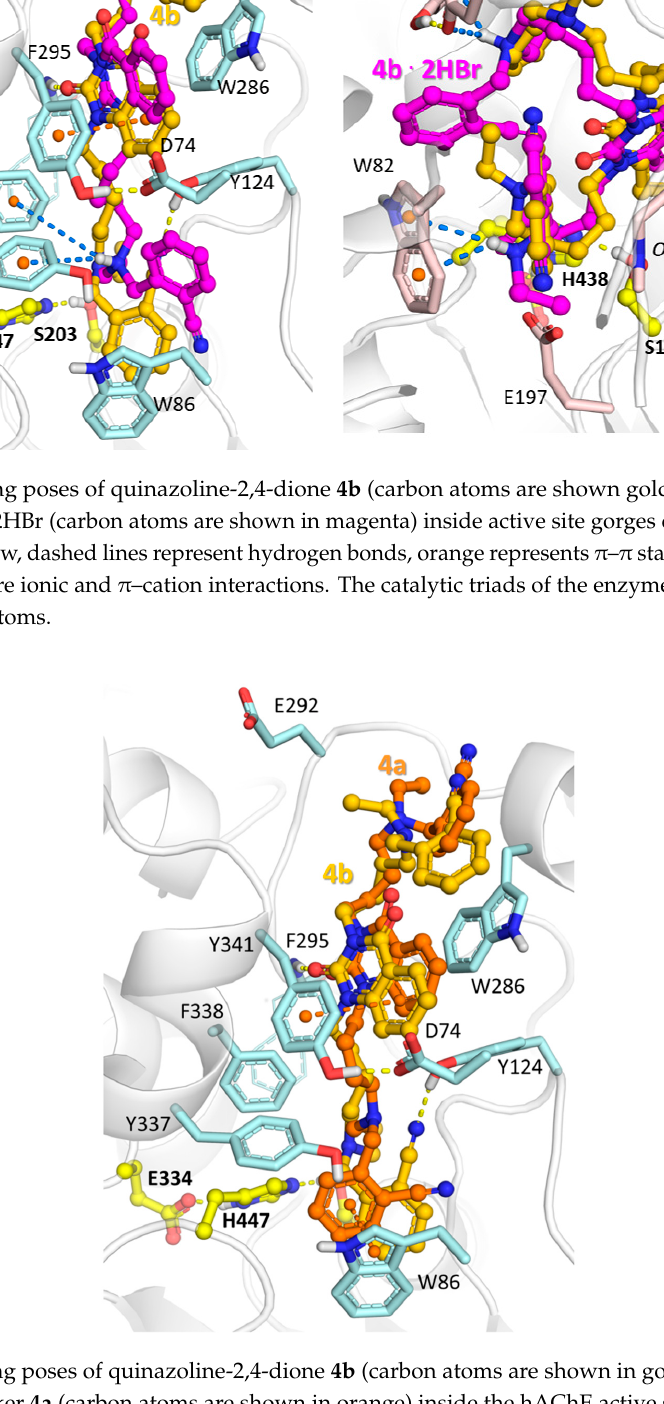
Figure 4. Binding poses of quinazoline-2,4-dione 4b (carbon atoms are shown in gold) and its analog with shorter linker 4a (carbon atoms are shown in orange) inside the hAChE active site gorge. Yellow, dashed lines show hydrogen bonds, orange represents π – π stacking interactions, and blue lines indicate ionic and π –cation interactions.